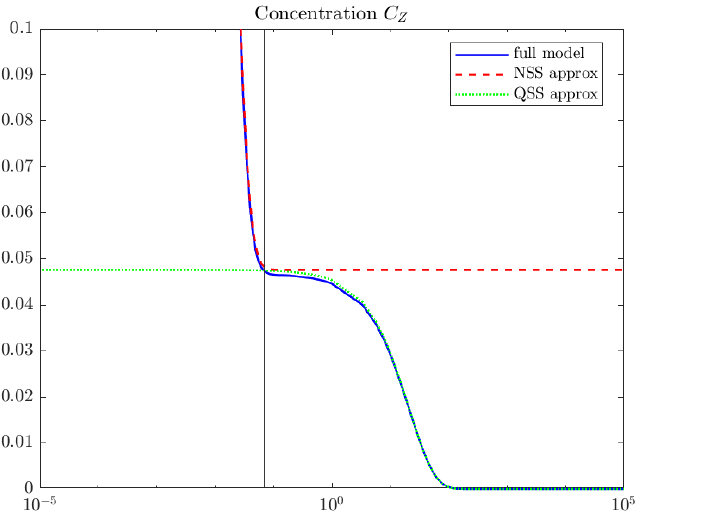
Figure 2. Concentration of